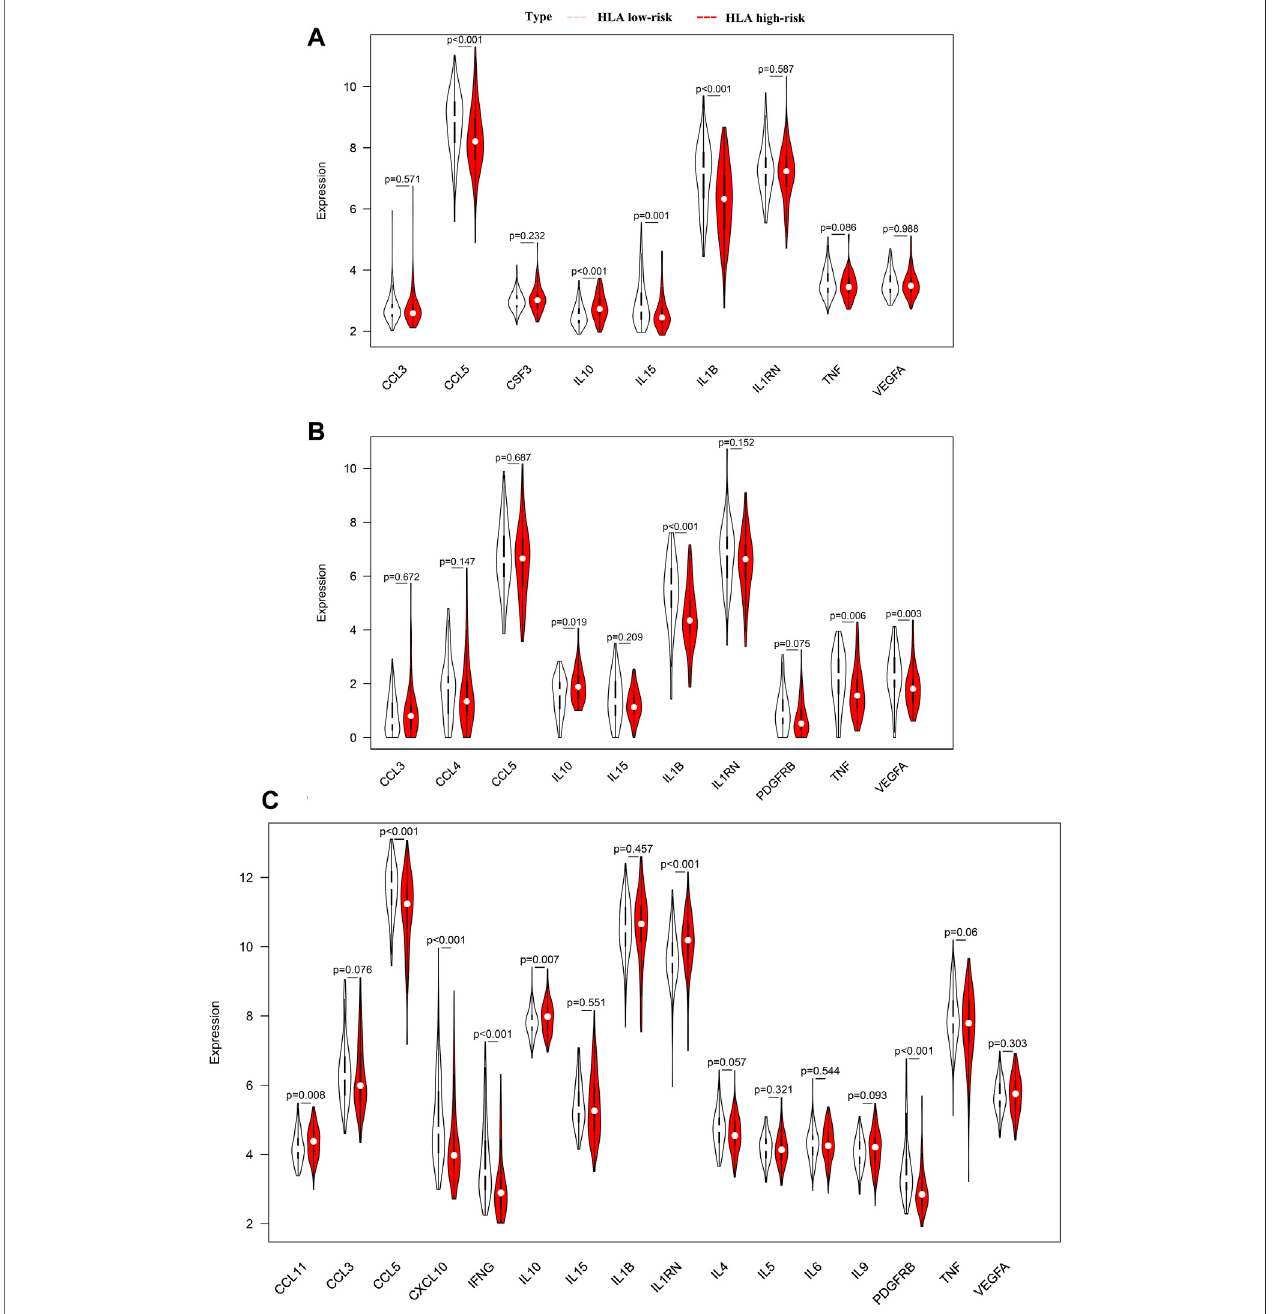
FIGURE 11 | Comparison of the expression level of cytokines between different HLA subgroups in multiple transcriptome datasets. (A) GSE65682 datasets. (B) GSE63042 datasets. (C) E-MTAB-4421 datasets. Pink indicates HLA low-risk, while red indicates HLA high-risk.